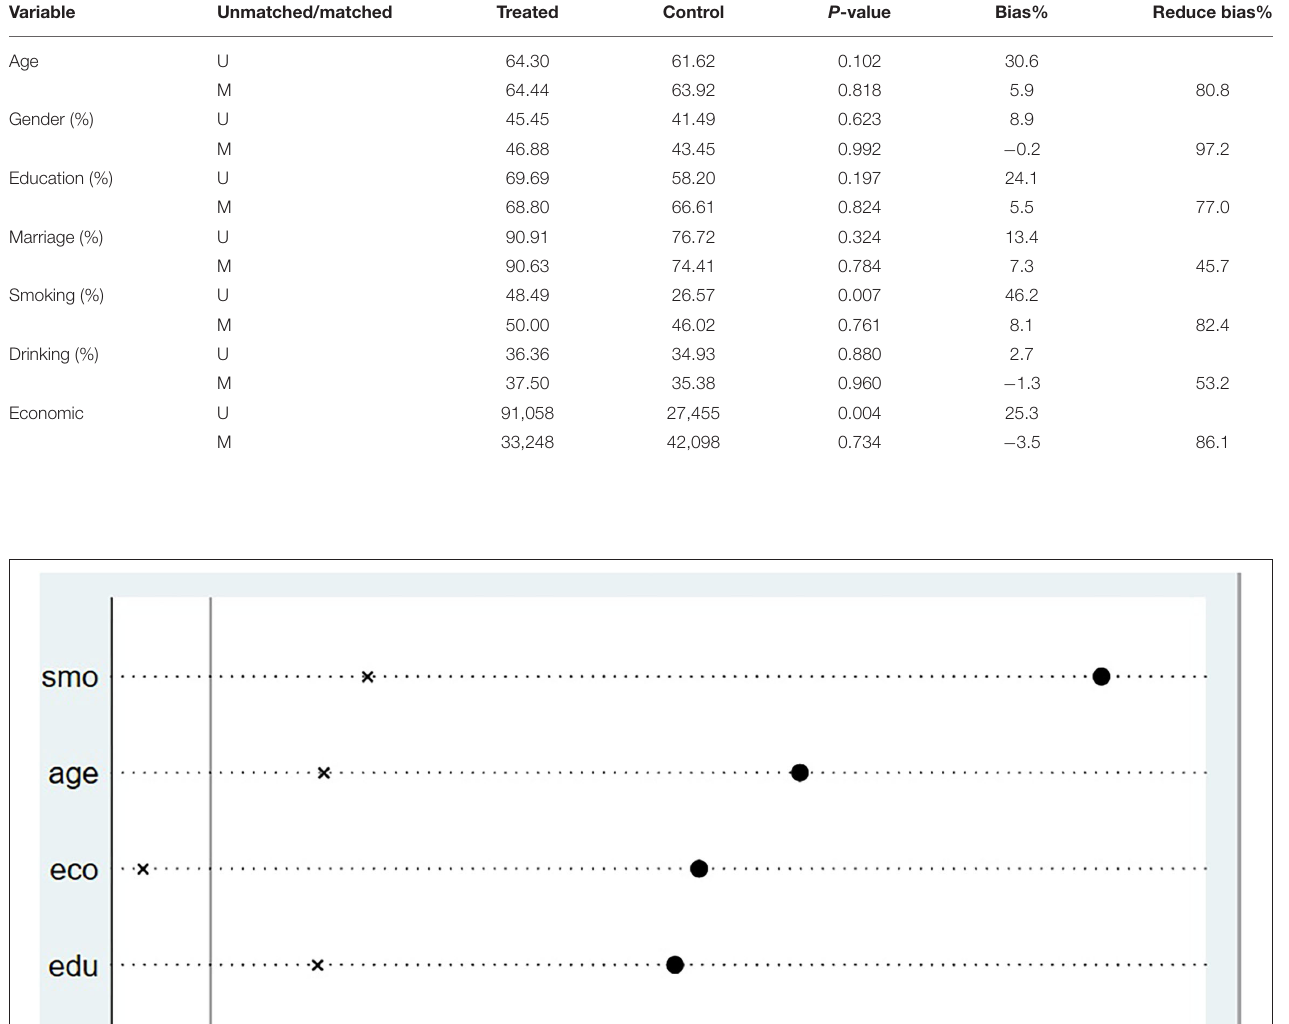
TABLE 2 | Covariate balance test before and after matching. Variable